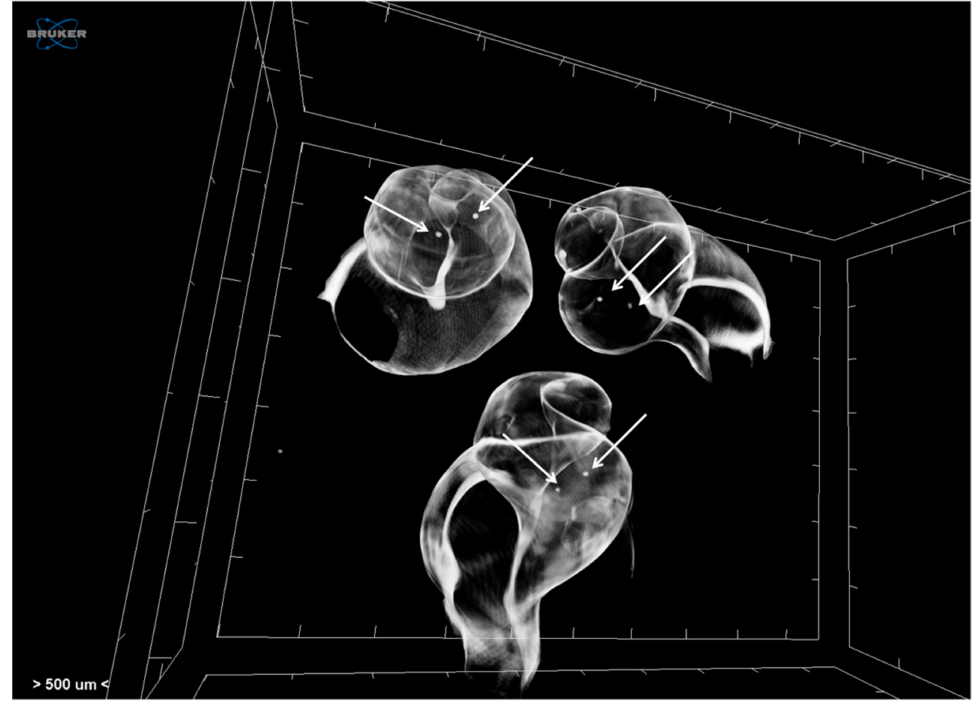
Figure 6. Volume rendering of juvenile Hexaplex trunculus acquired using a Skyscan 1172 micro-CT scanner, where internal calcified structures (statoliths, indicated with white arrows) are also